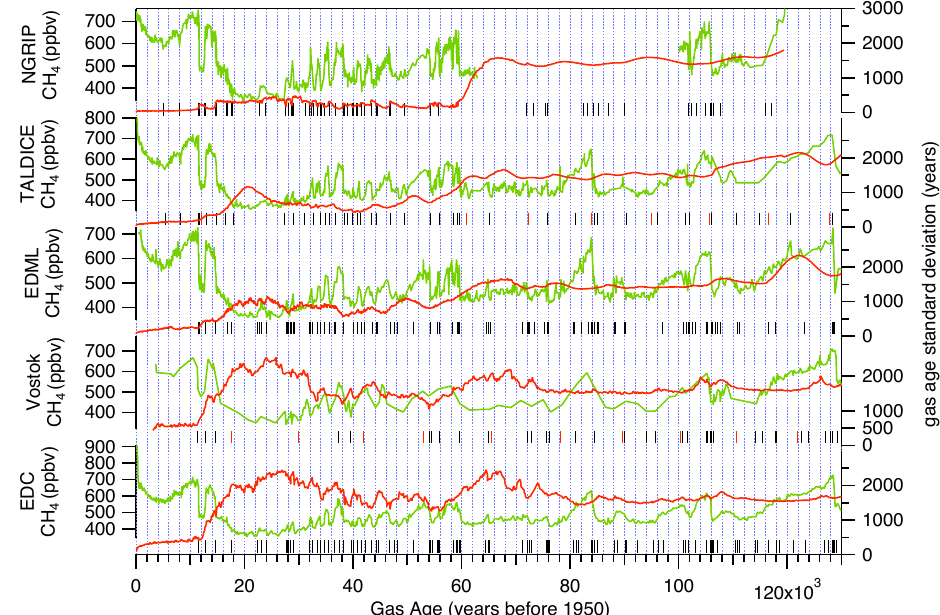
Fig. 2. The methane records of the five ice cores analyzed. From top to bottom: NGRIP (Greenland composite: Fl¨uckiger et al., 2004; Huber et al., 2006; EPICA Community Members, 2006; Schilt et al., 2010; Capron et al., 2010), TALDICE (Buiron et al., 2011; Sch¨upbach et al., 2011), EDML (EPICA Community Members, 2006), Vostok (Caillon et al., 2003; Petit et al., 2009) and EDC (Loulergue et al., 2008) on the AICC2012 gas chronology. Vertical black bars indicate the location of the gas stratigraphic markers and red bars the location of the absolute tie points in the gas phase. The red lines (right axes) show the gas age standard deviation in years for each of the ice core analyzed.